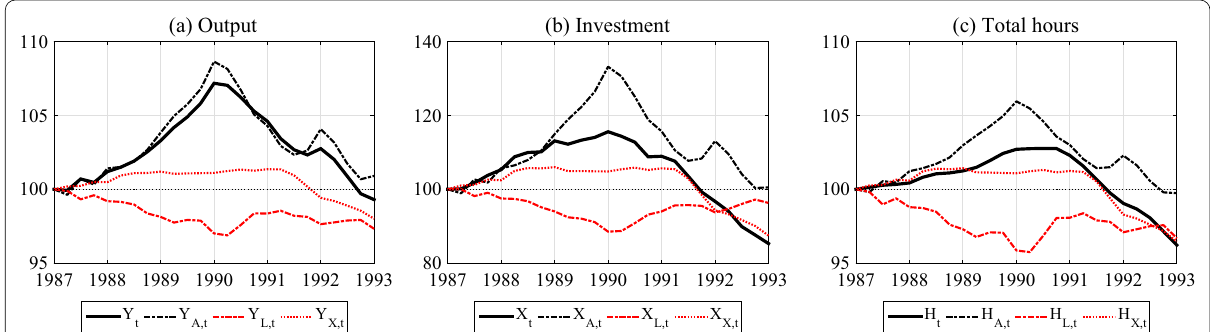
Fig. 12 Robustness: The 1987Q1–1993Q1 period for ν = 0.5 . The subscripts A , L , X denote the efficiency-, labour-, and investment-wedge-alone components of output Y t , investment X t , or total hours H t